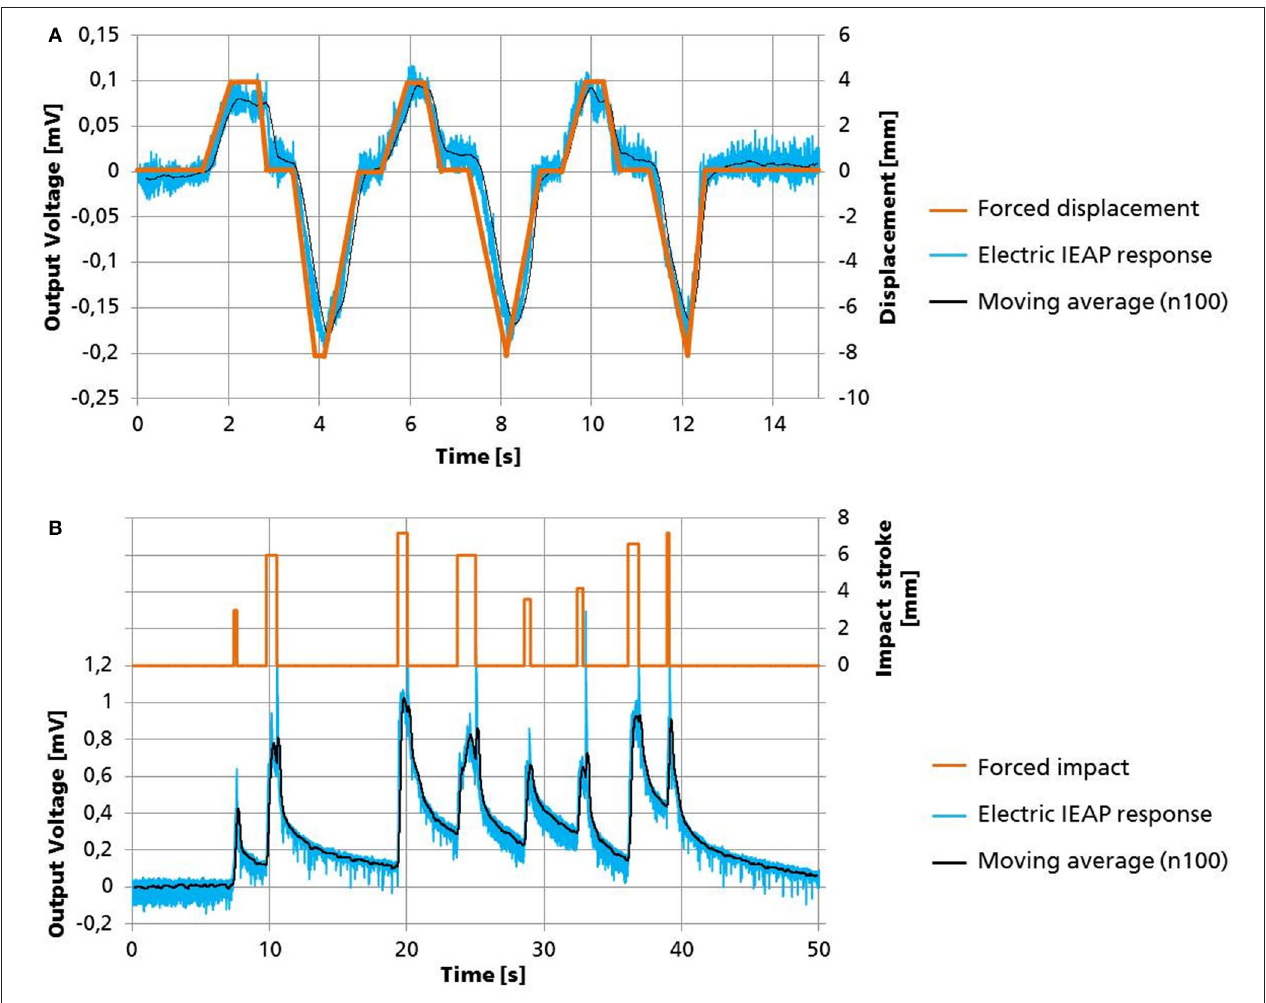
FIGURE 13 | Results of IEAP sensitivity tests. (A) Voltage response obtained from the smooth forced flap displacement scenario with deflections in both inward and outward directions. (B) Voltage response for forced impact and release